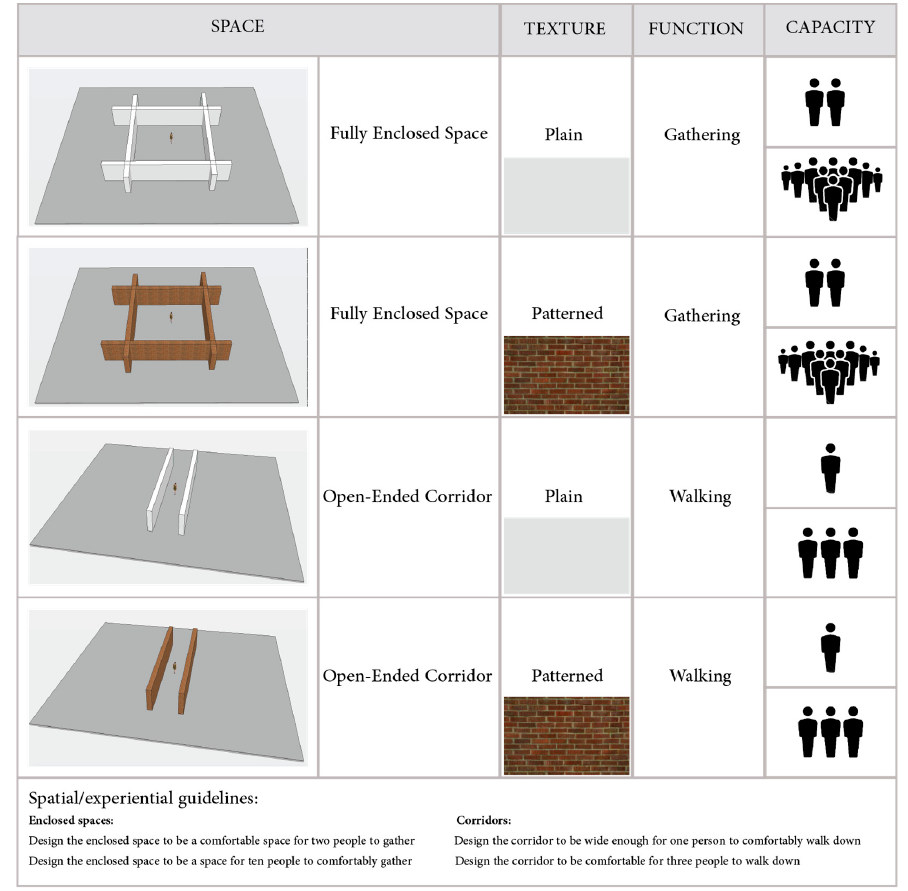
Figure 2. Developed models and adapted spatial/experiential guidelines for each space.